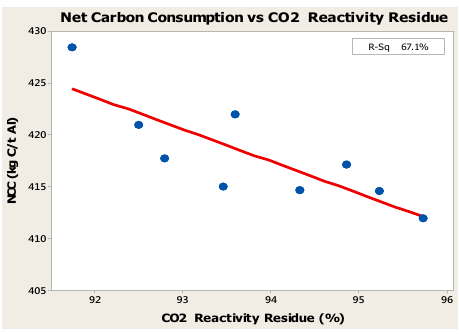
Figure 16. Net carbon consumption (NCC) vs. CO2 RR.